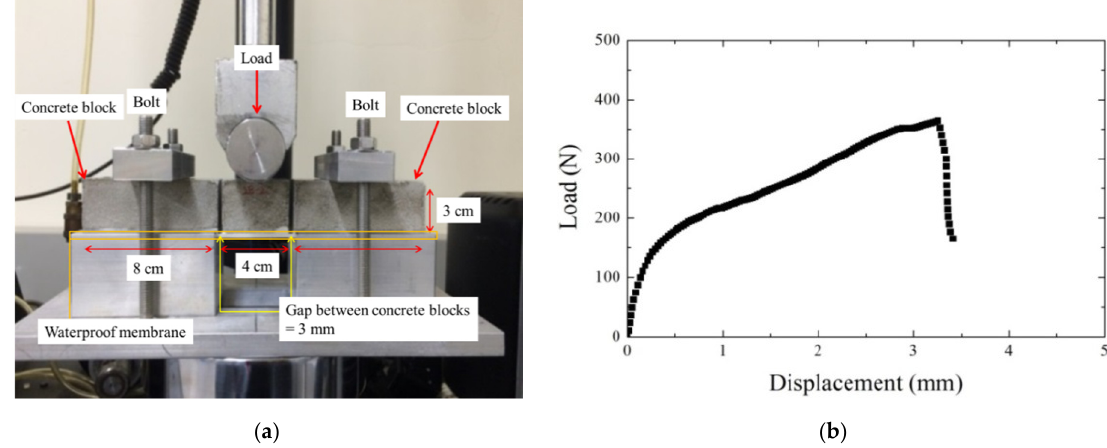
Figure 7. Linear block support test proposed by EFNARC [10]: ( a ) setup and ( b ) results.